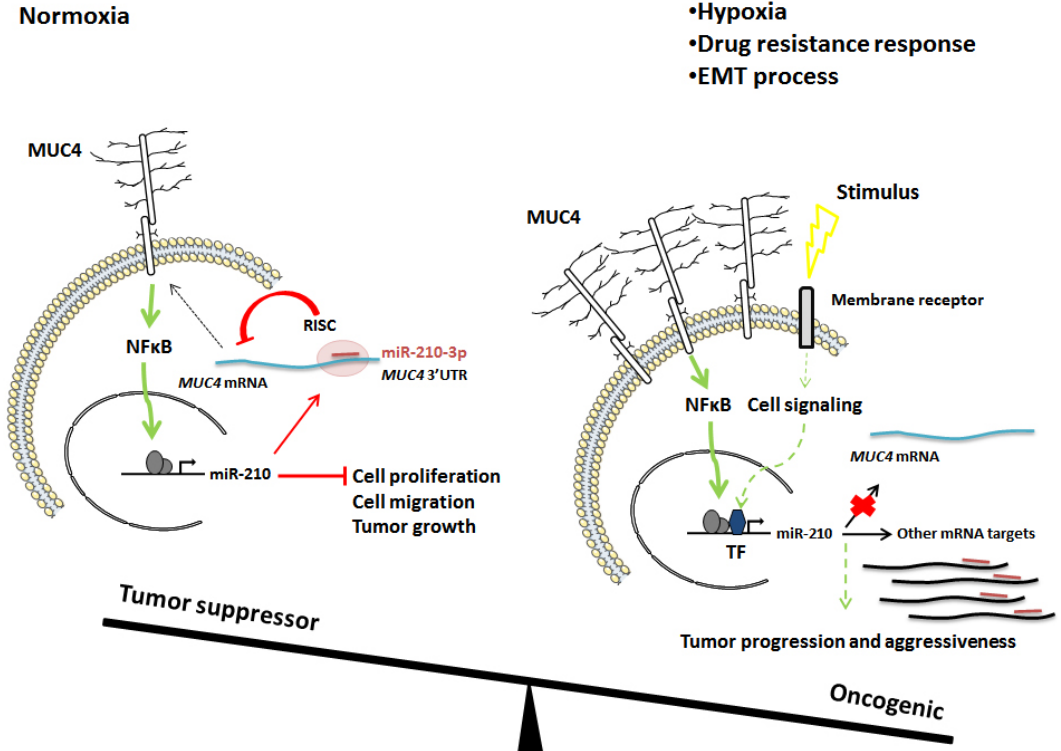
Figure 8. Schematic representation of overall miR-210-3p tumor suppressor/oncogenic effects in PDAC cells. Left: MUC4-miR-210-3p negative feedback loop that we identified under normoxic conditions. Right: Hypothetical model of miR-210-3p regulation and roles under hypoxia, drug resistance or metastasis signaling. Green arrows represent activating signals. Red arrows represent inhibitor signals. Short red line represents miR-210-3p. RISC: RNA-induced silencing complex. TF: transcription factors.